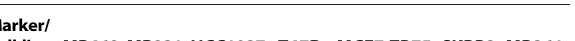
Table 1. Different human breast cancer cell lines expressed different known solid cancer stem cell